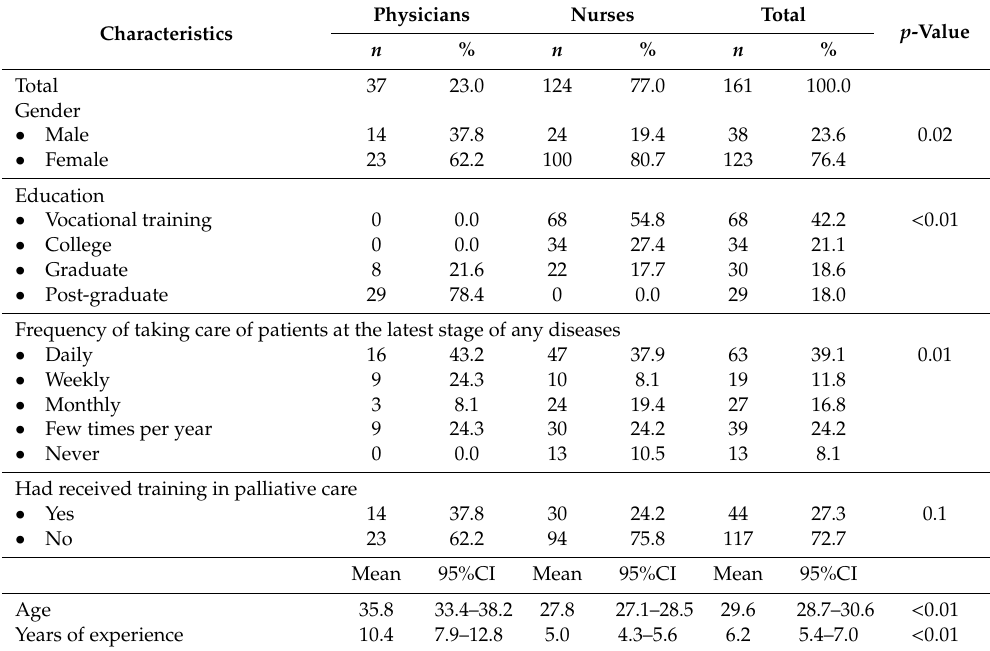
Table 1. Characteristics of